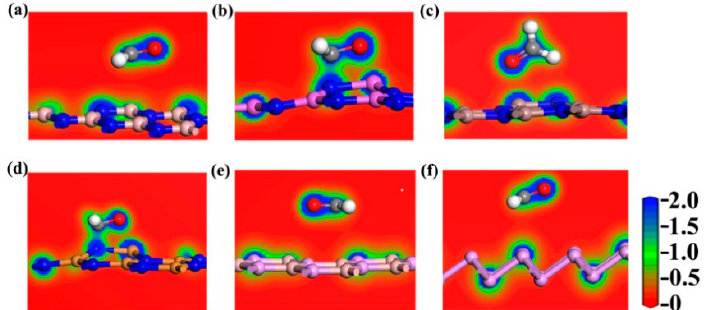
Figure 6. Slices of charge densities for the CH 2 O adsorbed on the ( a ) BN, ( b ) AlN, ( c ) GaN, ( d ) InN, ( e ) BP, and ( f ) P monolayers. The charge density ranges from 0 to 2 e/A 3 .